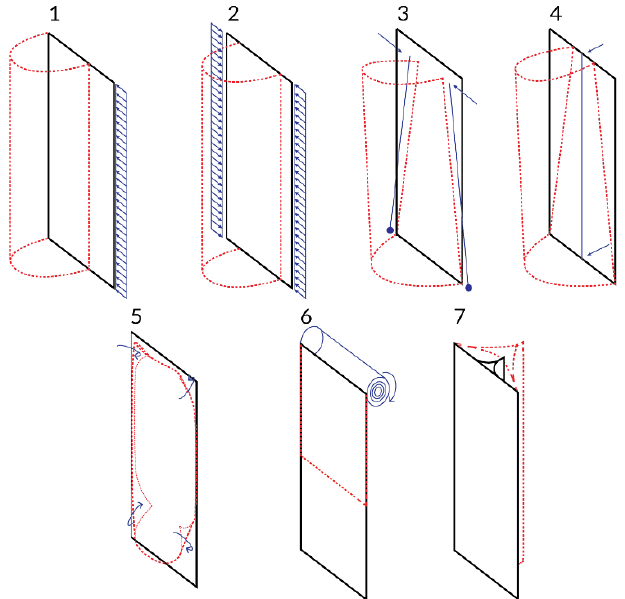
Fig. 8 Movement solutions based on the potential use of thin glass (Figure